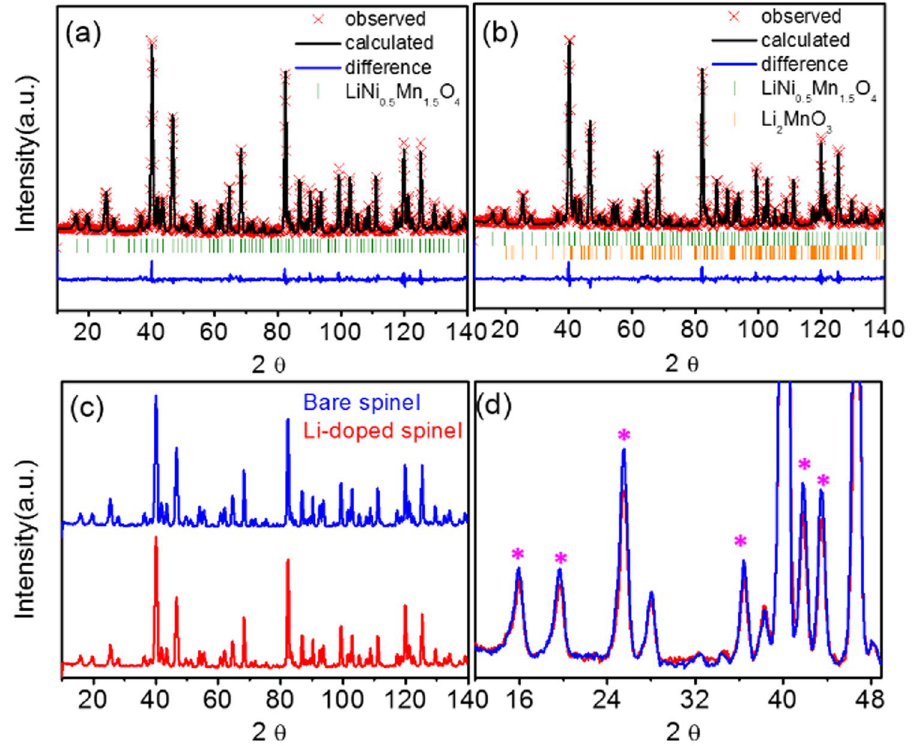
Figure 1. Representative refinement profiles of powder neutron diffraction (ND) of ( a ) bare − 700 °C sample and ( b ) Li-doped − 700 °C sample. The Bragg peak positions are for LNMO spinel (green bare) and for Li 2 MnO 3 (orange bar) ( c ) comparison the Neutron diffraction and ( d ) cthe superstructure peak of bare − 700 °C sample and Li-doped − 700 °C sample (diffraction peaks corresponding green: LNMO spinel, orange: Li 2 MnO 3 ).